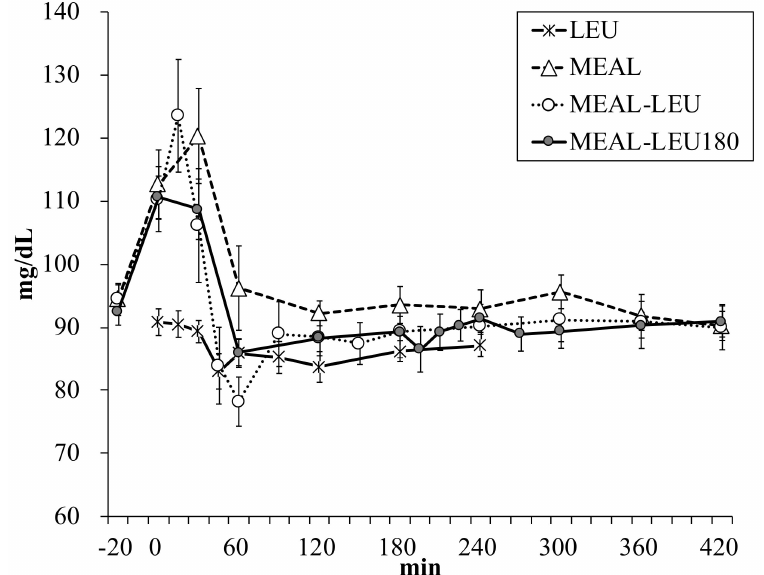
Figure 4. Mean ± SE ( n = 10) blood glucose concentration changes over time. LEU, intake of leucine